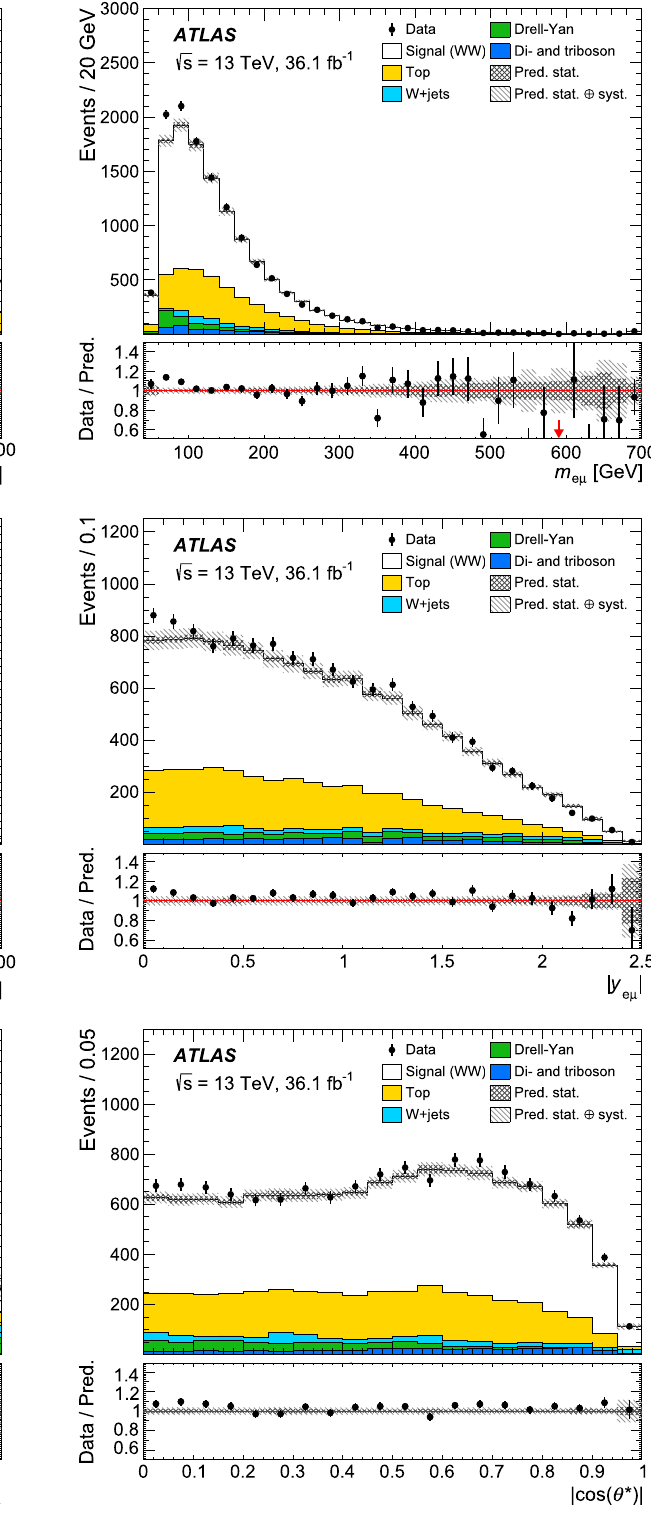
Fig. 4 Kinematic distributions of the selected data events after the full event selection (from left to right and top to bottom): p lead (cid:5) | y | , (cid:6)φ | cos θ ∗ | . Data are shown together with the predictions e μ e μ and of the signal and background production processes. Statistical and sys-